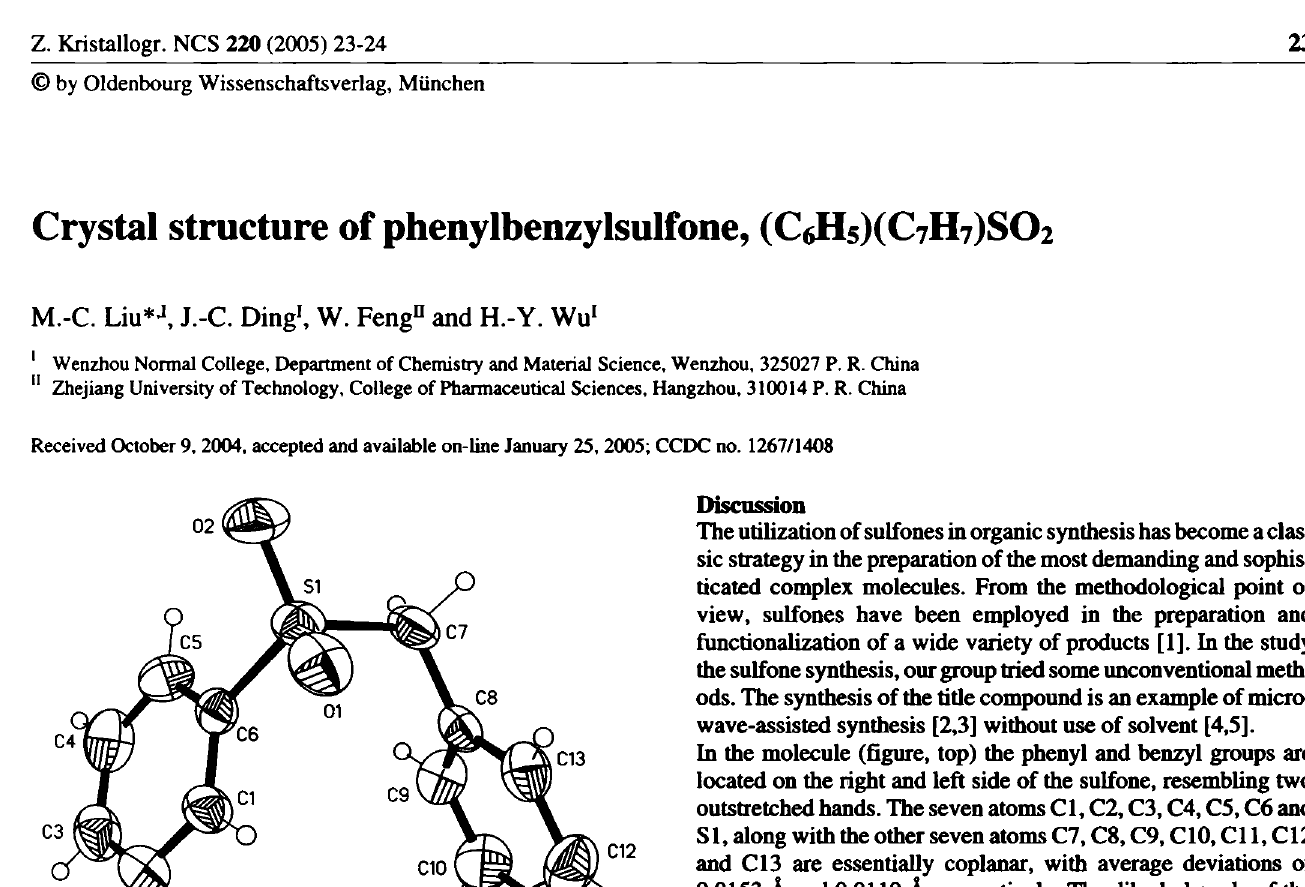
Table 1. Data collection and handling.